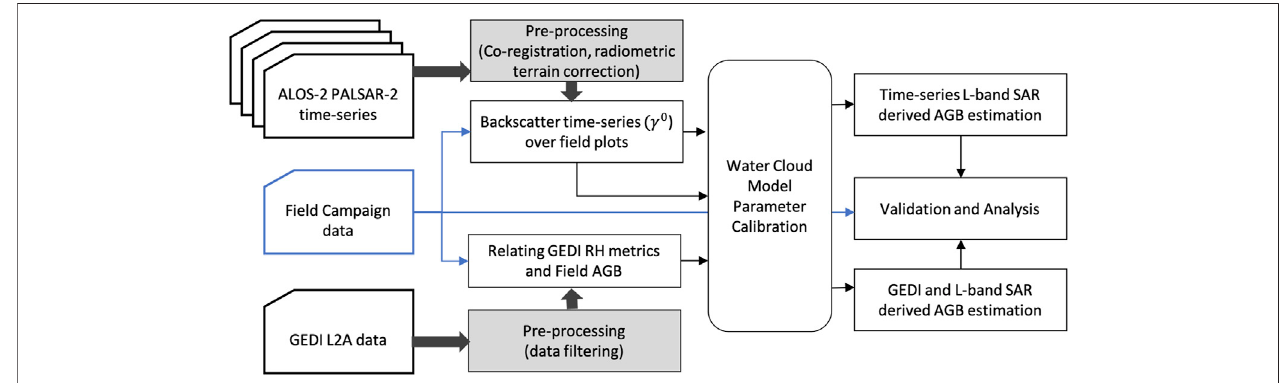
FIGURE 6 | The fl ow diagram showing the overall methodology followed in this